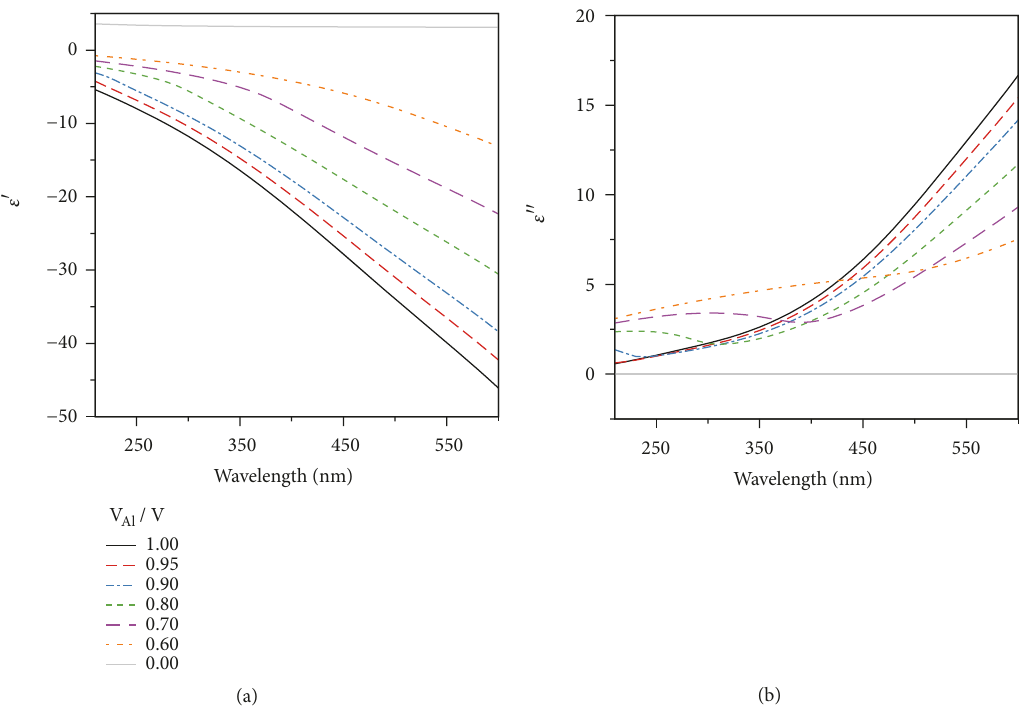
Figure1:ComplexdielectricfunctionforAl+Al 2 O 3 calculatedwiththeeffectivemediumapproach.Forthecomplexpermittivity, 휀 = 휀 󸀠 +푖휀 󸀠󸀠 , we show the real, (a), and imaginary, (b), parts for particles with varying volume fractions of Al, where 0 corresponds to pure Al 2 O 3 and 1 to pure Al